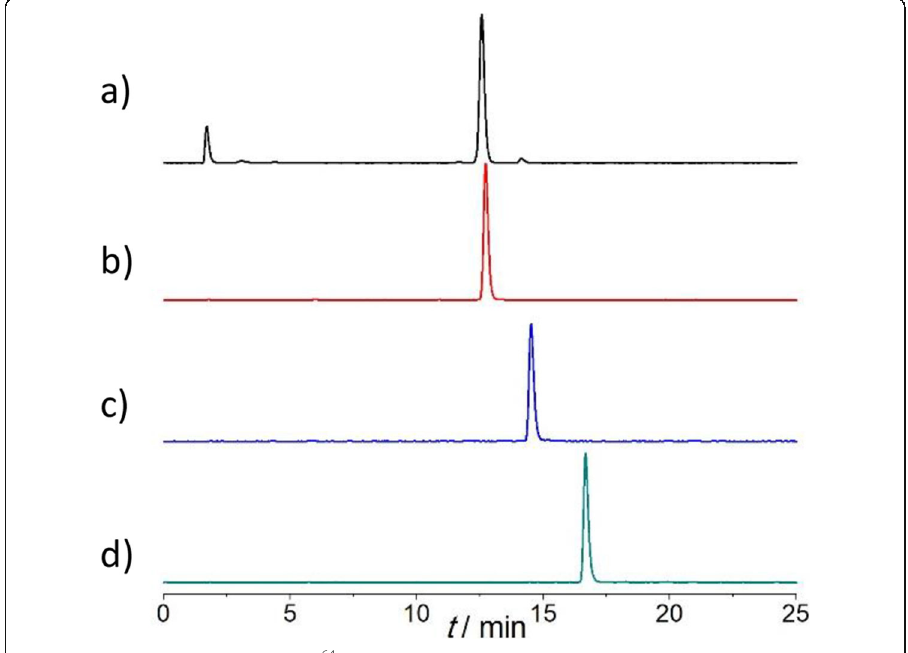
Fig. 2 Radio-HPLC chromatogram of 64 Cu labeling of ( a ) DOTA-1Py (retention time, t R = 12.5 min), ( b ) DOTA-2Py (t R = 12.7 min), ( c ) DOTA-3Py (t R = 14.5 min), and ( d ) cyclen-4Py (t R = 16.7 min) at ligand concentration 1 × 10 − 3 M (100 nmol ligand, 3 MBq 64 Cu) and ambient